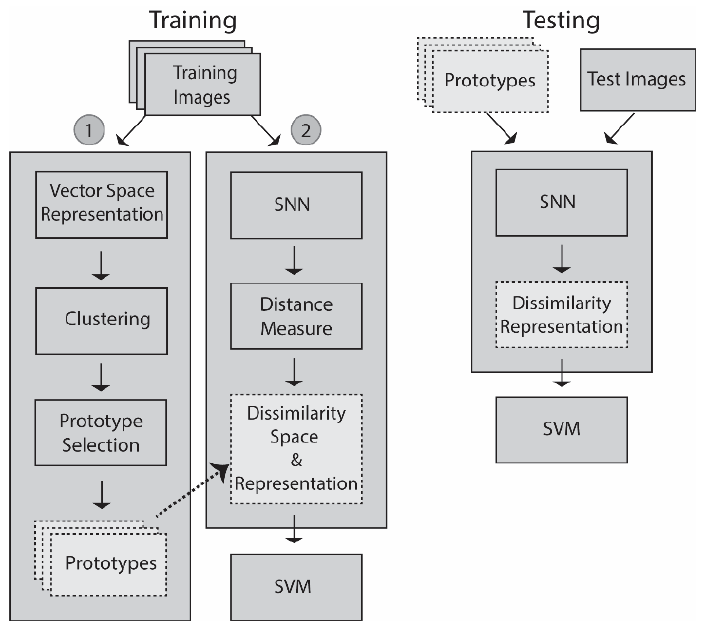
Figure 1. Schematic of the basic dissimilarity architecture using one SNN with the output fed into one SVM.